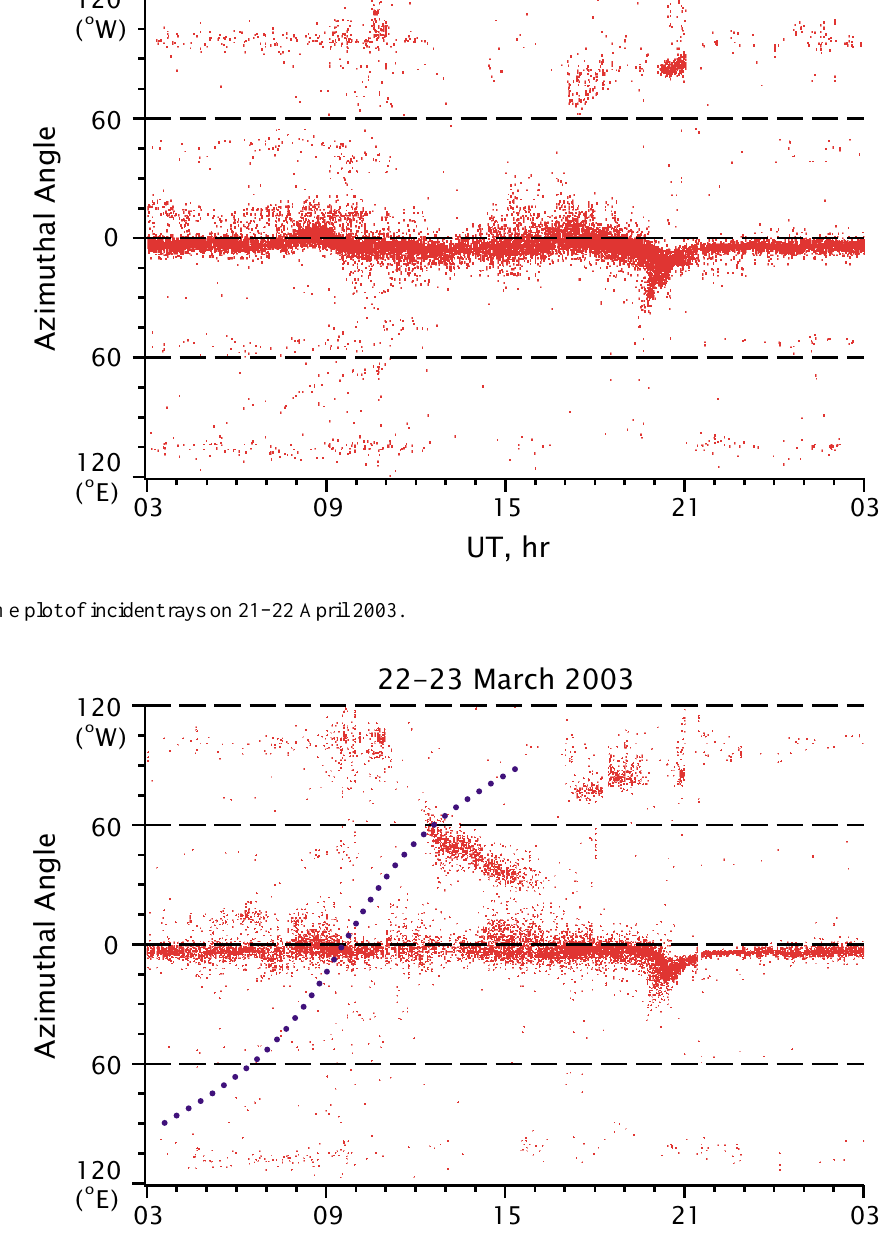
normal direction by 09:30 UT. After this, the trace shifted eastward and gradually returned to the normal direction through the night. This pattern was basically repeated ev- ery day and we interpreted it as a terminator effect. Similarly, near the sunrise terminator, the ray direction shifted eastward and gradually returned to the normal daytime direction. This pattern was also repeated every